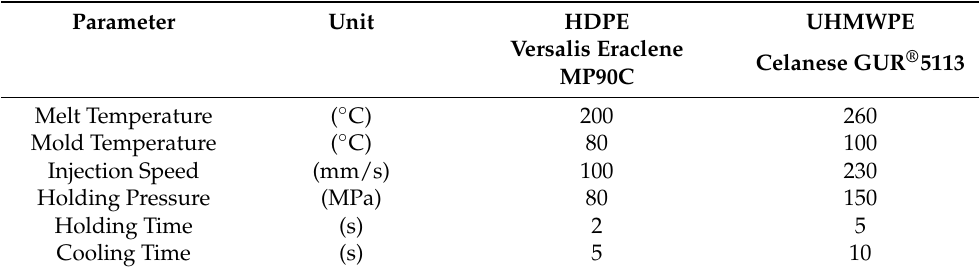
Table 6. Micro-injection molding process parameters.